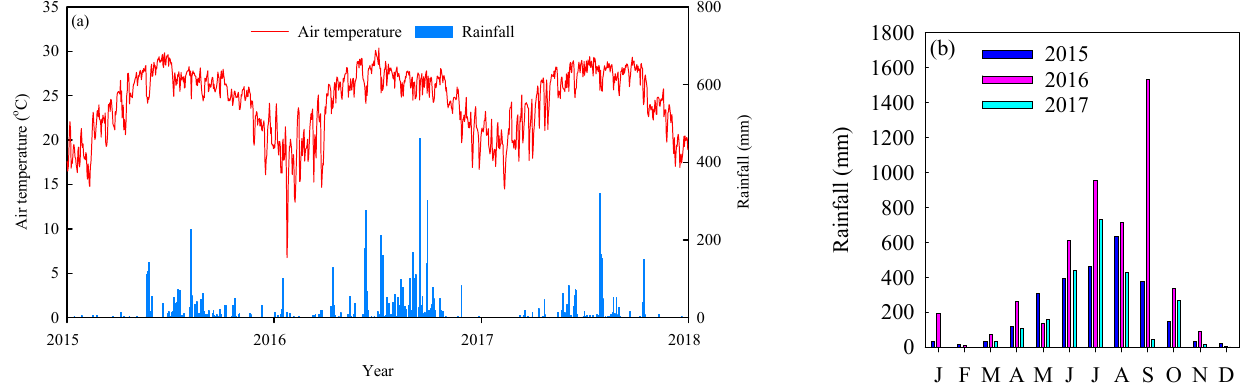
Figure 1. The mean ( a ) daily air temperature, soil moisture, rainfall and ( b ) monthly rainfall from 2015 to 2017.